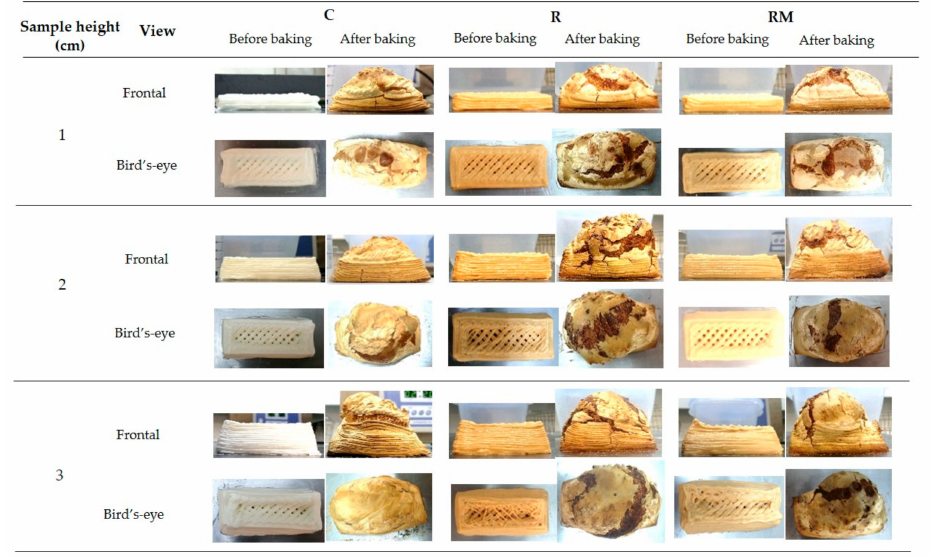
Figure 3. 3D printed samples front and bird’s-eye view before and after baking process. (C, control; R, rosehip; RM, encapsulated